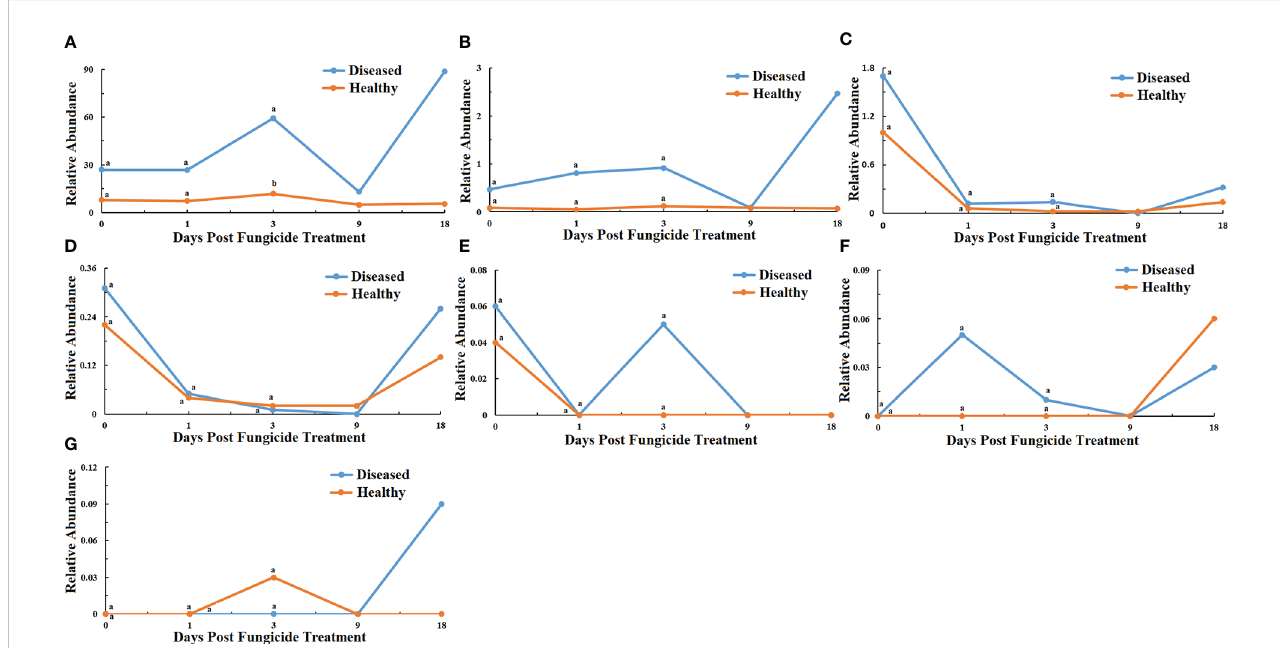
FIGURE 2 Changes in bacterial community compositions at the phylum level for diseased and healthy leaves over time after azooxystrobin treatment. (A) Proteobacteria, (B) Actinobacteria, (C) Firmicutes, (D) Bacteroidetes, (E) Deinococcus-Thermus, (F) Synergites, (G) Acidobacteria. Statistical analysis was not performed for results of diseased samples at 9 and 18 dpt as there was only one